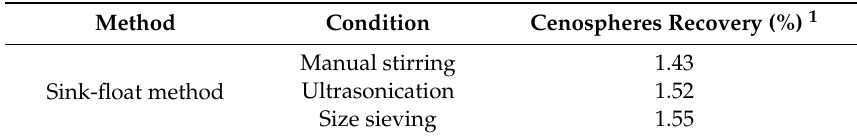
Table 3. Data comparing the recovery yield of cenospheres collected from different experimental conditions, particularly using fly ash-water ratio of 1:10 (10 wt. %).